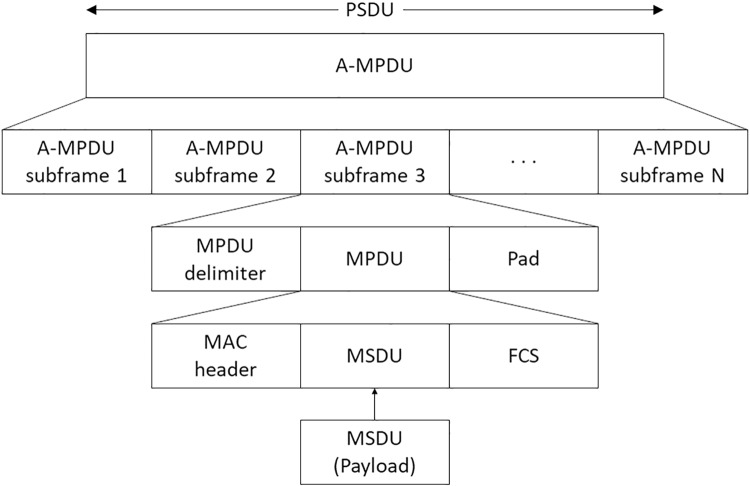
The frame format for A-MPDU [1, 9–11].